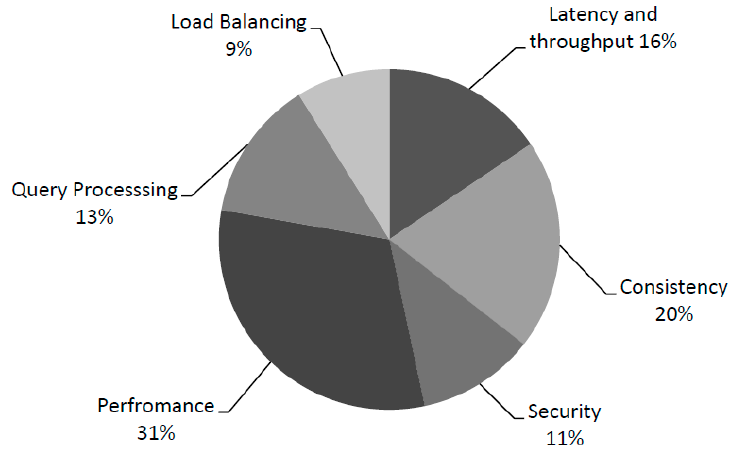
Figure 6. Solutions provided in each class.